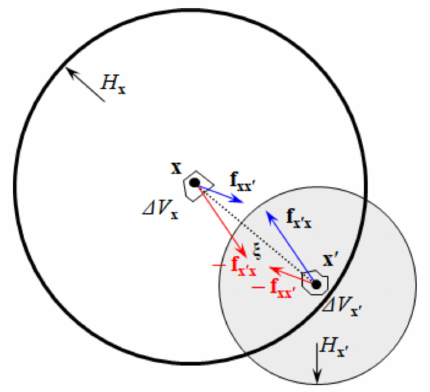
Figure 2. Force vector in peridynamics with varying